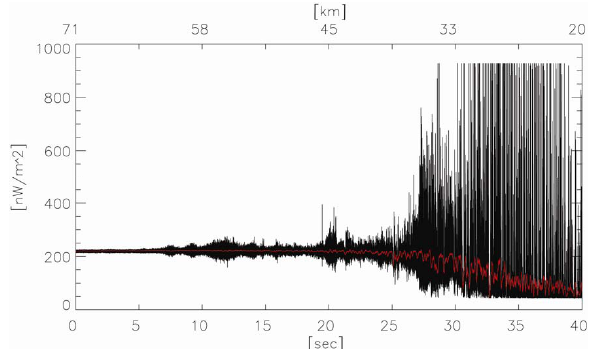
Figure 3 Optical power detected at OPALE, 07:22:00 UTC was set to 0 in this plot, where the red line is the mean calculated from 0.1 second intervals. Fig. 3. Optical power detected at OPALE, 07:22:00UTC was set Figure 4 shows the corresponding scintillation index Eq. (1) computed at 0.1 s intervals, which steeply increases around 30 seconds. The same is true for the angular fluctuation of to 0 in this plot, where the red line is the mean calculated from the incoming beam expressed in the angular correction performed by the fine pointing 0.1s intervals. mechanism (FPM) in the x- and y-directions (shown in Fig. 5 and 6). The x- and y- directions are referenced with respect to the FPM’s coordinate system which is defined by the incoming beam representing the z- axis with x- and y- axes are perpendicular to it. Thus the geometry with respect to the Earth could only be derived knowing the exact attitude (azimuth and elevation) of the CPM. Since this data is not readily available conclusions concerning specific horizontal and vertical effects can not be drawn. It is evident in the plots that the fine pointing mechanism also gets saturated after 30 seconds and can not compensate for the deflections of the incoming beam any more. The general pattern is similar to that of power received by the detector. The constant low level of corrections at earlier times is most likely to be attributed to combined micro vibrations of ARTEMIS and OICETS; the atmospheric effects lead immediately to strong signal variations and saturation of the mechanism. Angle of arrival errors start to increase later at the ARTEMIS side than at the OICETS side but as mentioned the effects are immediately strong (Perlot, 2009). A closer look at the data reveals a small gradual increase of the average corrections applied (red line in the plots) but interrupted by numerous saturation events. This behaviour seems to be caused mainly by wavefront distortions. Thus the FPM data of ARTEMIS apparently has little useful information content with respect to atmospheric effects. The situation is potentially a little bit better on the OICETS side.